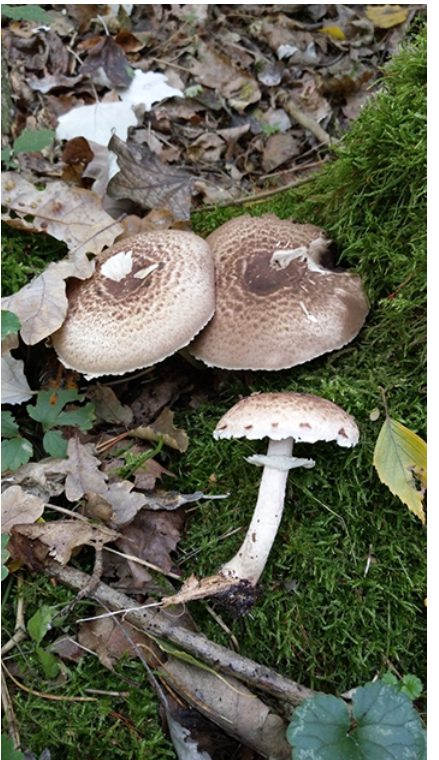
Figure 4 Basidiomata of Agaricus porphyrrhizon P. D. Orton. Photography by Anna